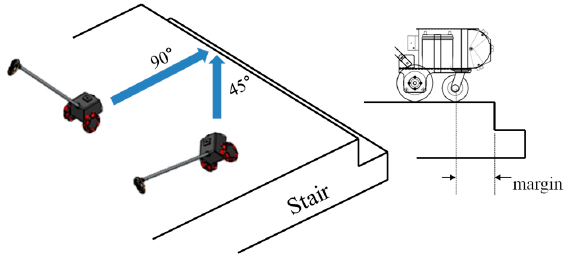
Figure 14. Experimental configuration for testing the braking system.